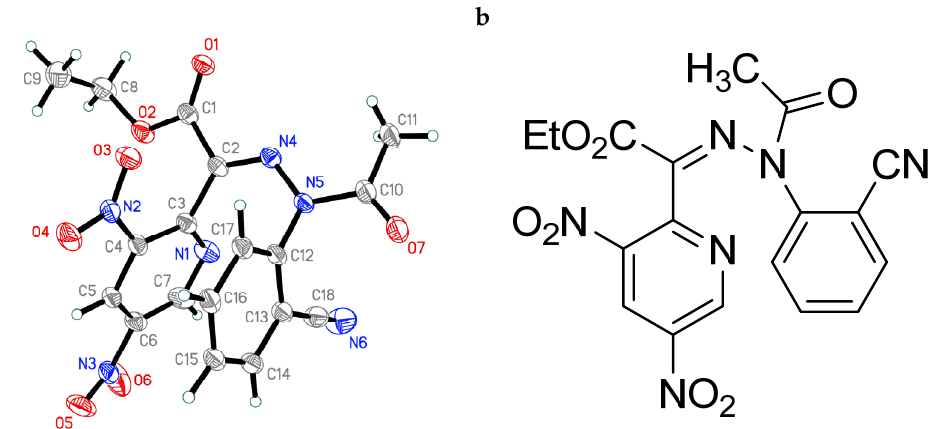
Figure 3. ( a ) X-ray crystal structure of compound 5a’ with thermal ellipsoids at a 50% probability level. Disorder of one NO 2 group is omitted, ( b ) structural formula of 5a’